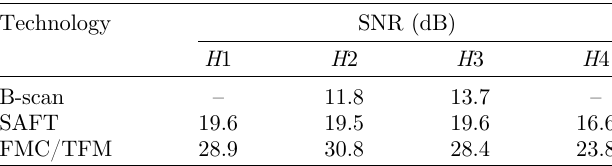
Table 1. The SNR values of different